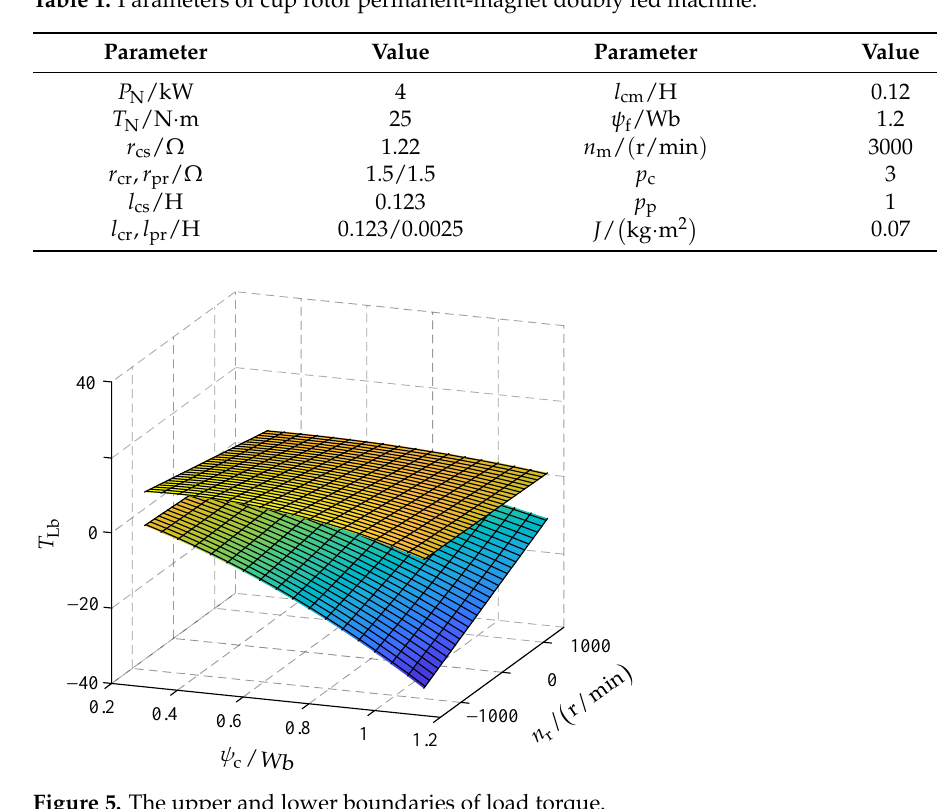
Table 1. Parameters of cup rotor permanent-magnet doubly fed machine.